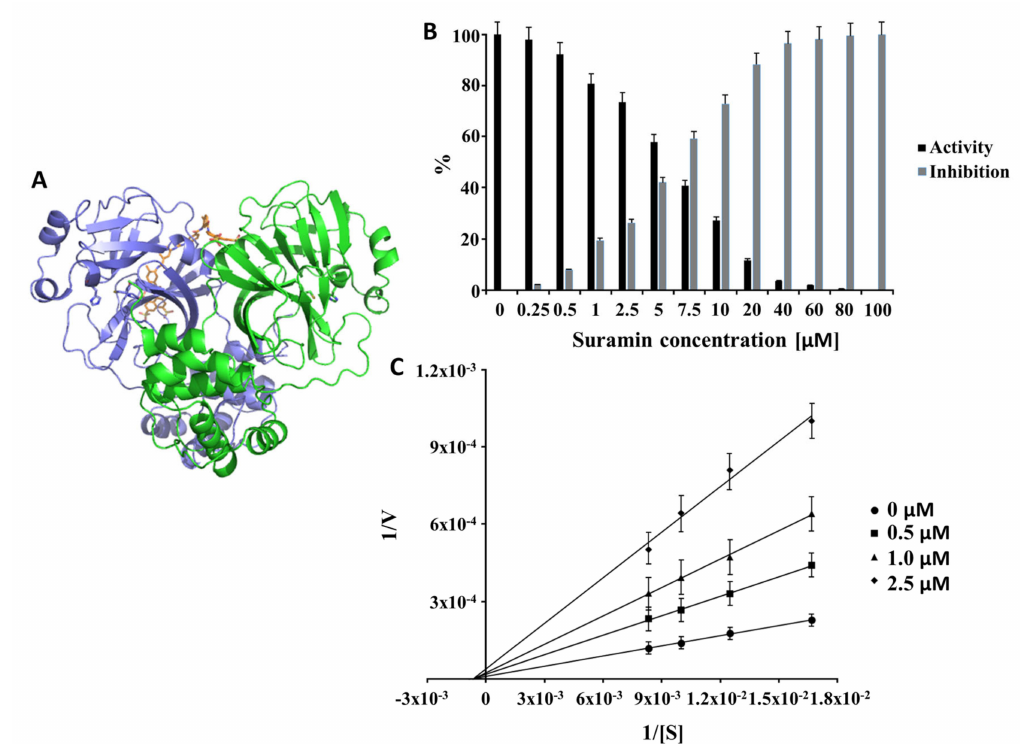
Figure 3. Inhibition effect and inhibition mode of suramin over SARS-CoV-2 3CL pro . ( A ) 3D representation of the 3CL pro - suramin complex (3CL pro are in ribbon presentation, and suramin is indicated by sticks). 3CL pro monomers are colored in green and blue and suramin in orange. Normalized activity and inhibition of the virus proteases and Lineweaver-Burk plots to determine the inhibition mode are presented. [S] is the substrate concentration; v is the initial reaction rate. ( B ) Normalized activity and inhibition of SARS-CoV-2 3CL pro under suramin influence. ( C ) Lineweaver-Burk plot for Suramin inhibition of SARS-CoV-2 3CL pro . Data shown are mean ± SD from 3 independent measurements ( n =